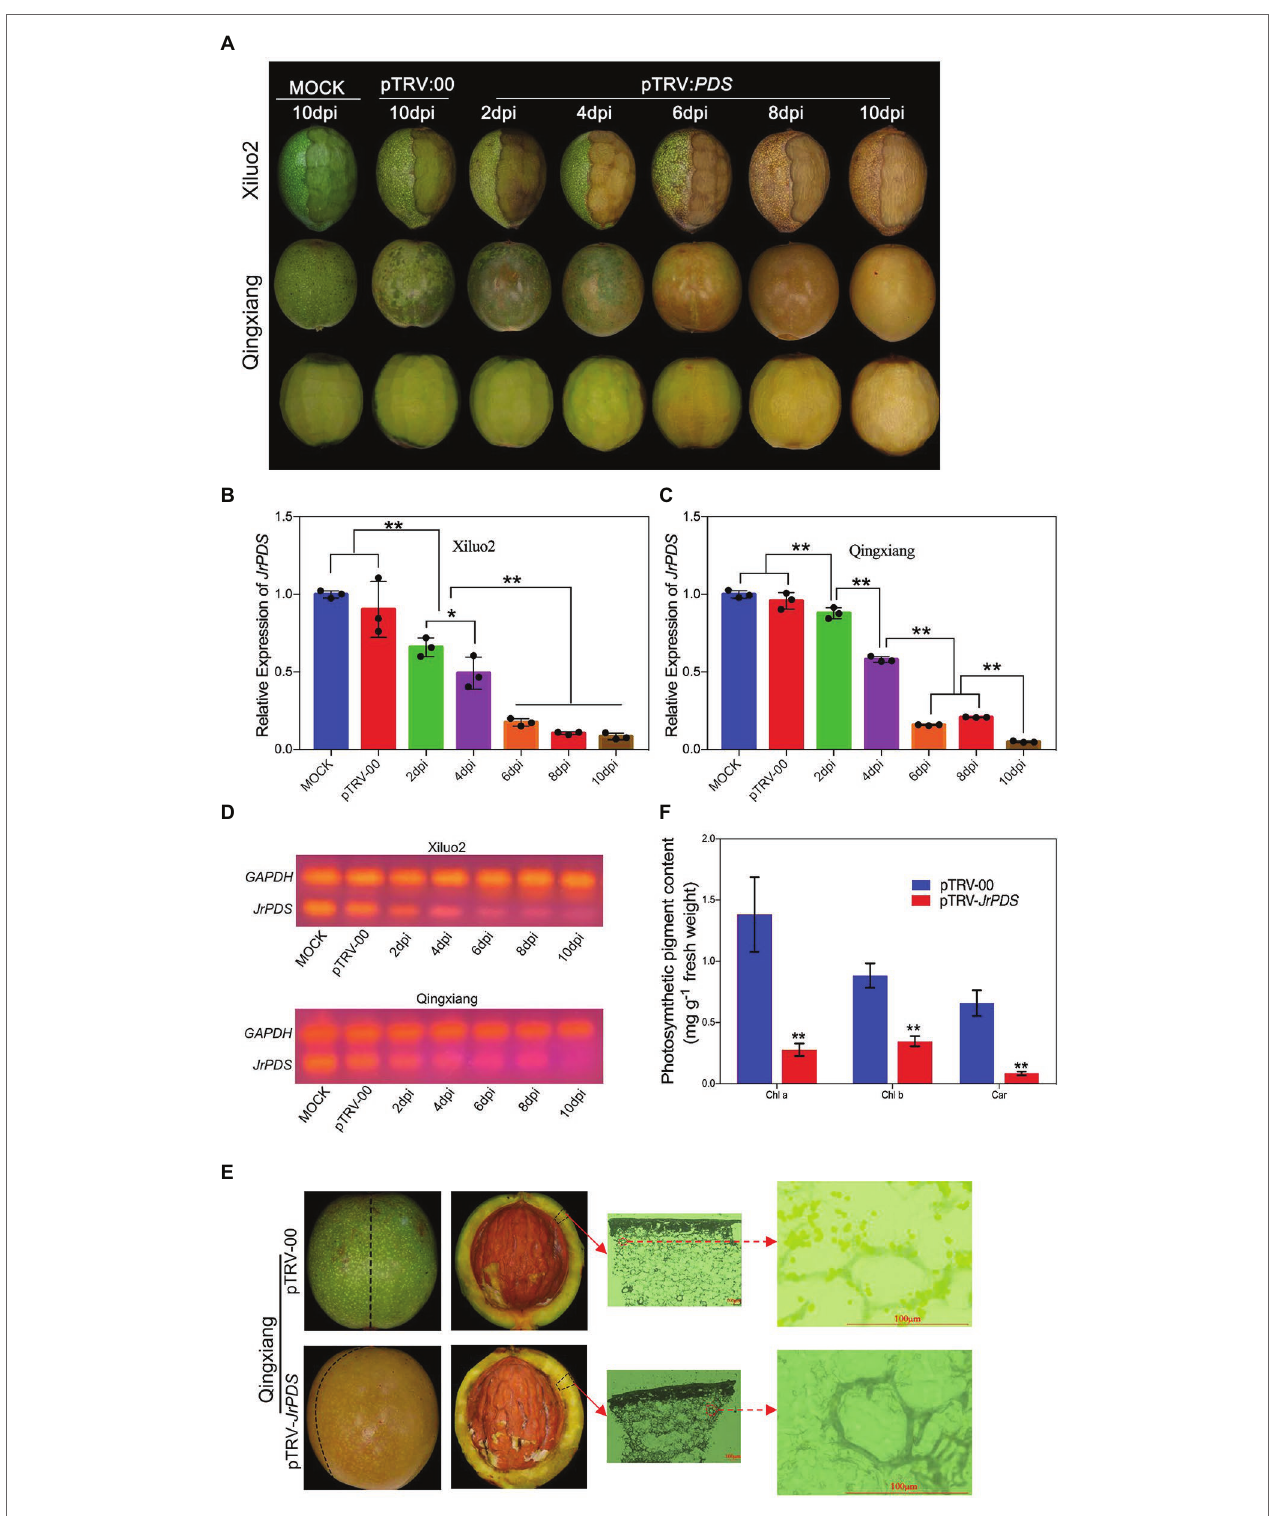
FIGURE 3 | JrPDS silencing in the fruits of cv. Qingxiang and Xiluo2 using the VIGS-TRV system generates a persistent photobleaching phenotype. (A) Fruit phenotype of cv. Qingxiang and Xiluo2 infected with Mock control, pTRV-00, and pTRV- JrPDS . The fruits infected with Mock and pTRV-00 were photographed at 10 dpi, while those infected with pTRV- JrPDS were collected and photographed every 2 days. A quarter of the outer hull was peeled for “Xiluo2” before